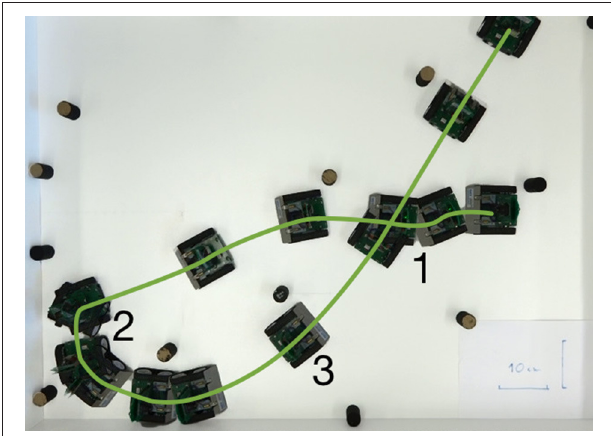
FIGURE 11 | Successful run in a cluttered environment with a modified neuronal architecture. Overlay of the overhead-camera